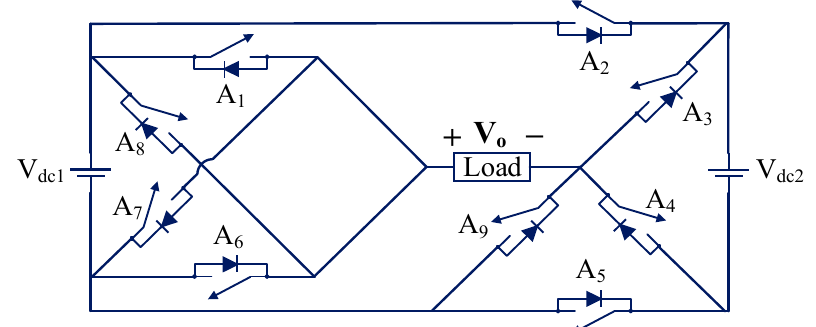
Figure 22. Single-phase five-level FT MLI (TP23) [38].